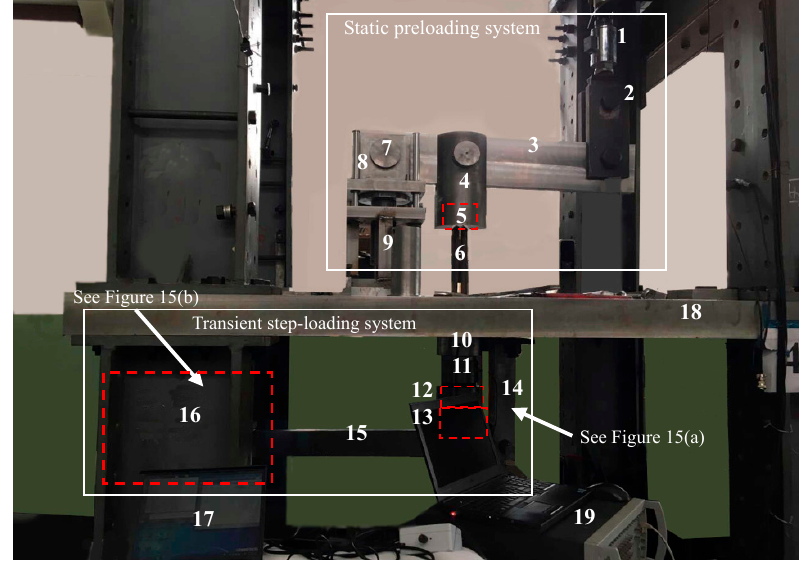
Figure 14. Experimental setup. ( 1 )-Hydraulic Press; ( 2 )-Lug (iii); ( 3 )-Beam (i); ( 4 )-Lug (ii); ( 5 )-Lockset (i); ( 6 )-Anchor cables; ( 7 )-Hinged end; ( 8 )-Lug (i); ( 9 )-Support (i); ( 10 )-Vibrating wire sensor; ( 11 )-Piezoelectric sensor; ( 12 )-Lockset (ii); ( 13 )-Lug (iv); ( 14 )-Support (ii); ( 15 )-Beam (ii); ( 16 )-Pulley mechanism; ( 17 )-DAE of vibrating wire sensor; ( 18 )-Platform; ( 19 )-LMS system.